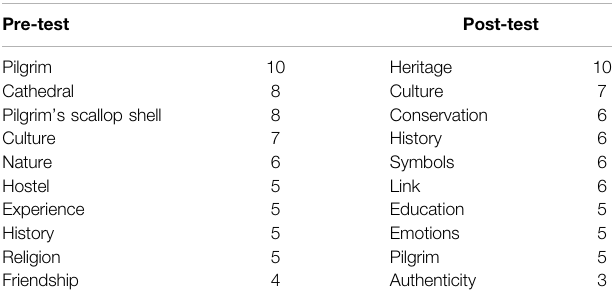
TABLE 4 | Top ten words with the highest incidence related with the Way of St.